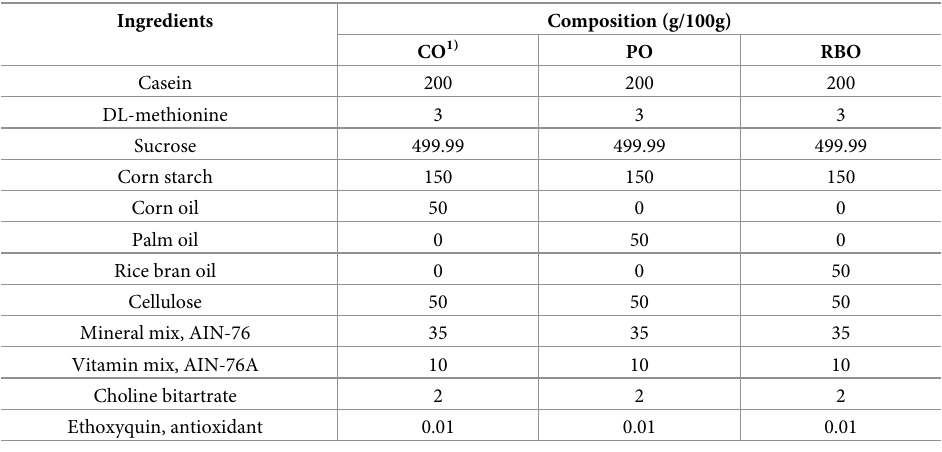
Table 1. Experimental diet